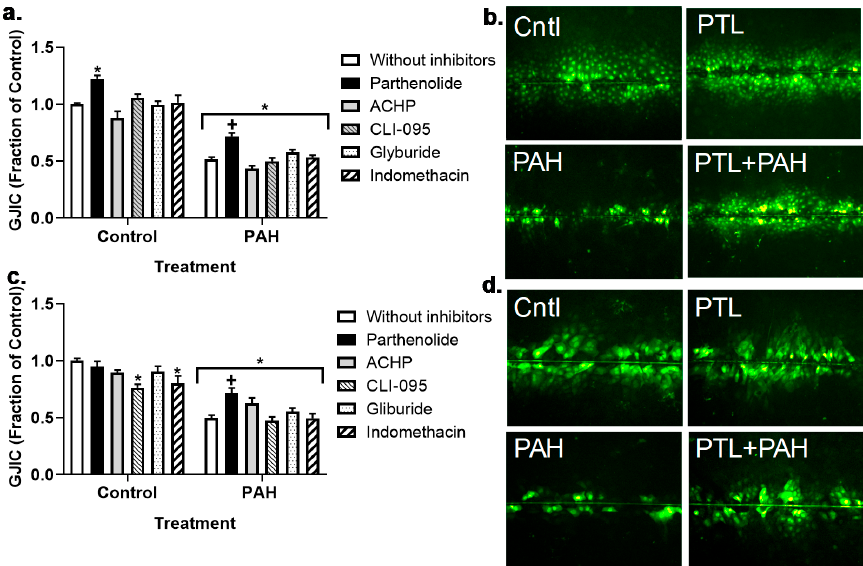
Figure 4. Gap junction intracellular communication (GJIC) dysregulation in response to LMW PAHs is reversed with parthenolide treatment at 24 h in both C10 and E10 cells. ( a ) C10 cells were treated with the binary LMW PAH mixture (15 µ M at 24 h; 1:1 ratio of 1-methylanthracene and fluoranthene)